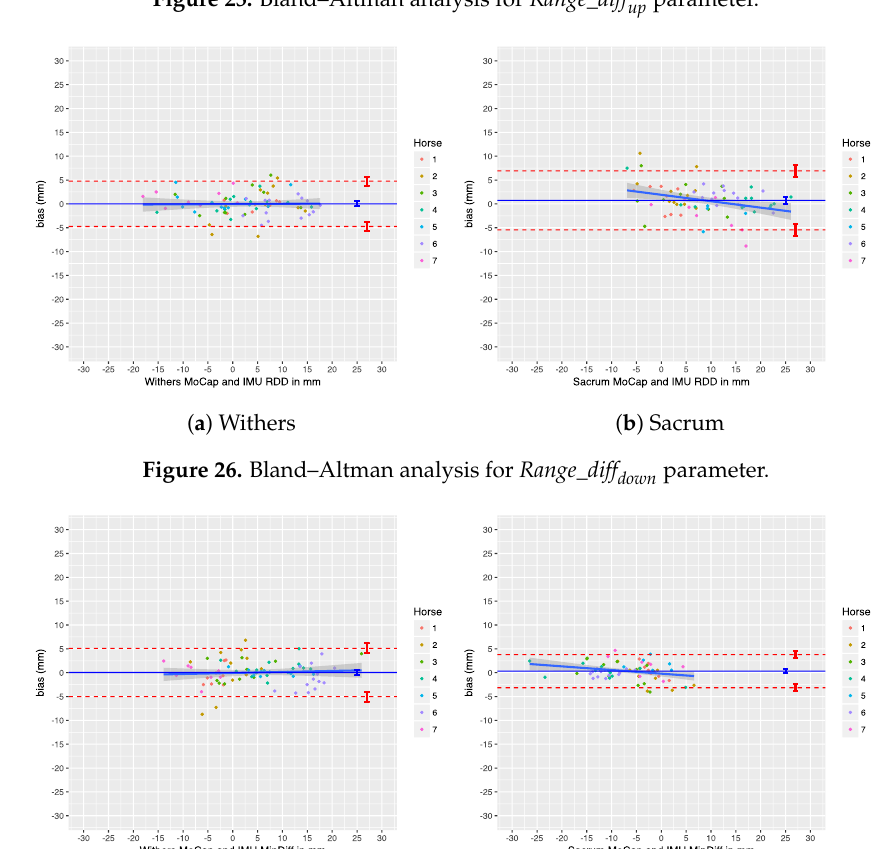
Figure 25. Bland–Altman analysis for Range_diff